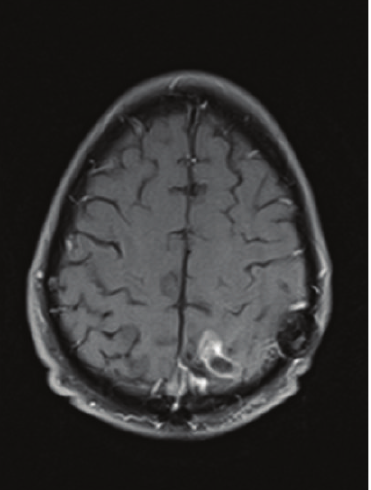
Figure 3: MRI scan showing increased enhancement, indicating tumorrecurrencetwenty-twomonthsafterGKRSsalvagetreatment.